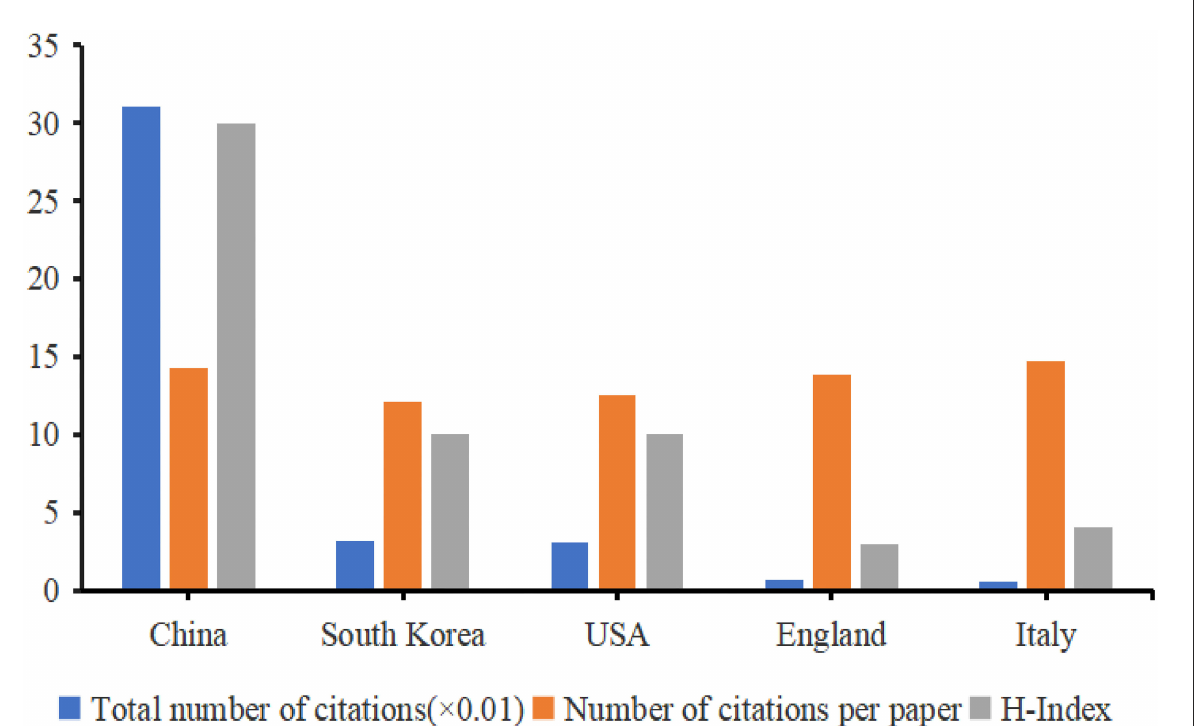
FIGURE6 The distribution of citation ( 0.01), number of citations per article, and H-index in the top 5 countries. According to the number of citations and × H-index, the histogram intuitively shows the top 5 countries, among which Chinese scholars have done the most research in this field and have the highest influence.